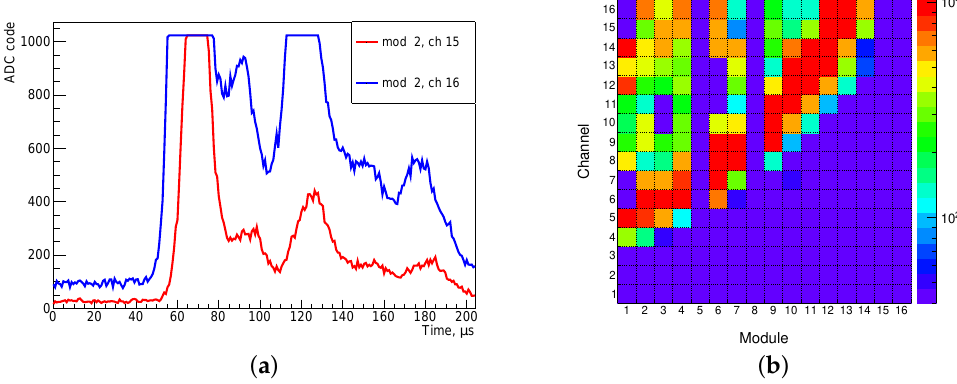
Figure 4. Example of a multi-elve. ( a ): waveforms of two pixels (15th and 16th) in the second module. ( b ): a pixel map at time 132 µ s from the beginning of the record.